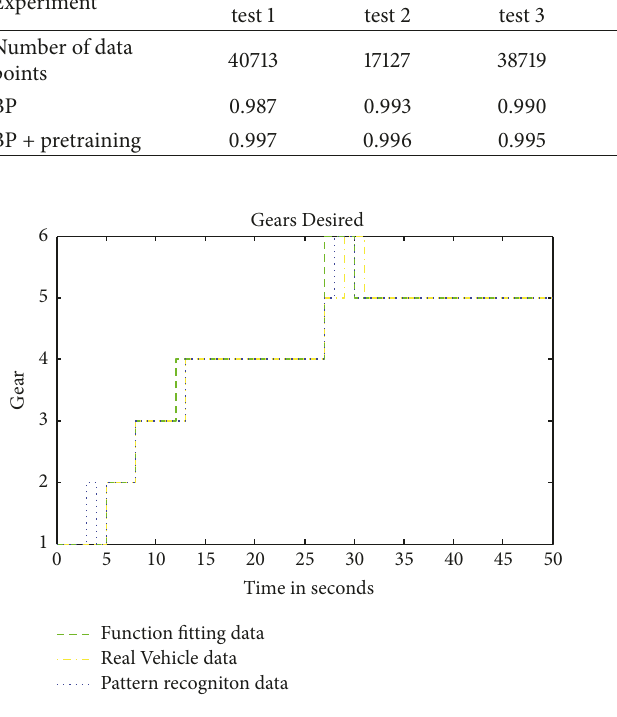
Figure 25: Gear timing of road test 5.